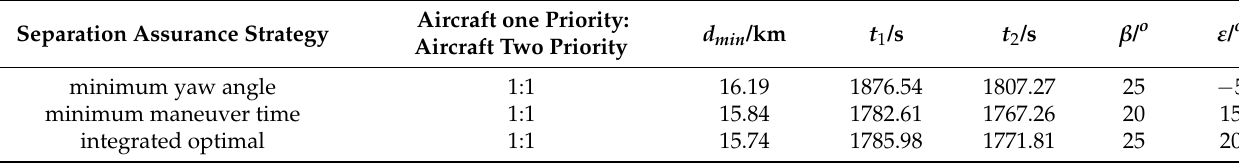
Table 3. Results of three separation assurance strategies.